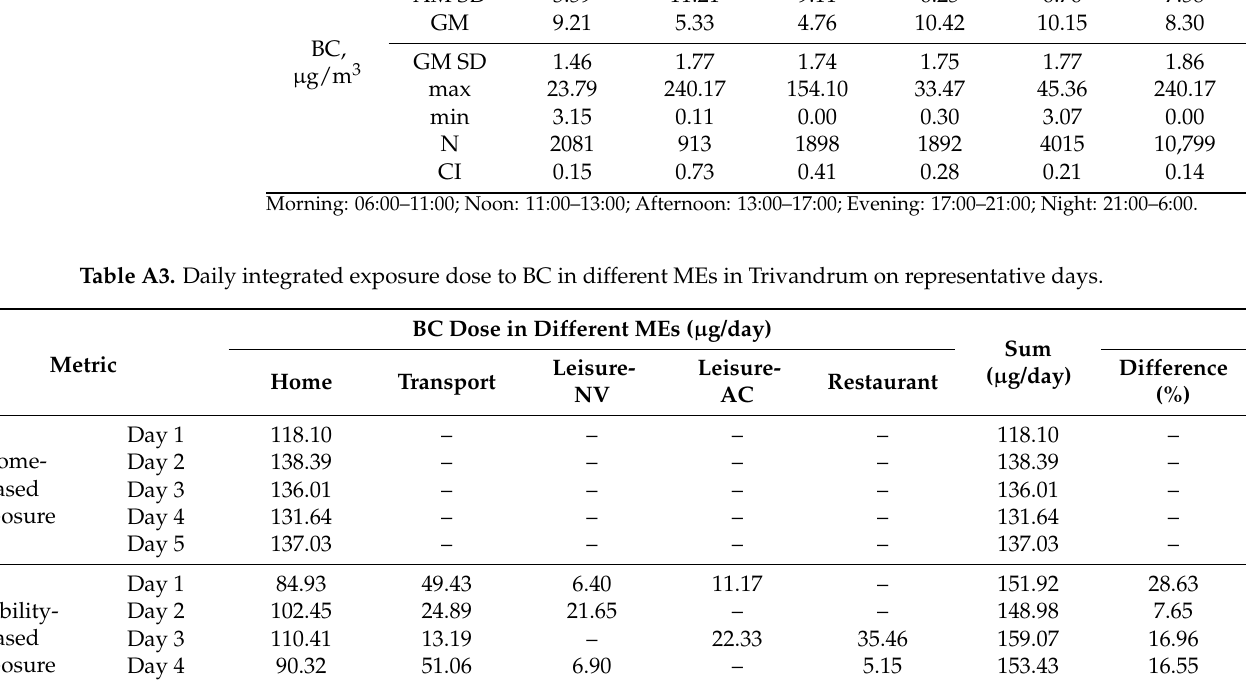
Table A2. BC personal exposure concentrations at home according to the time of the day.